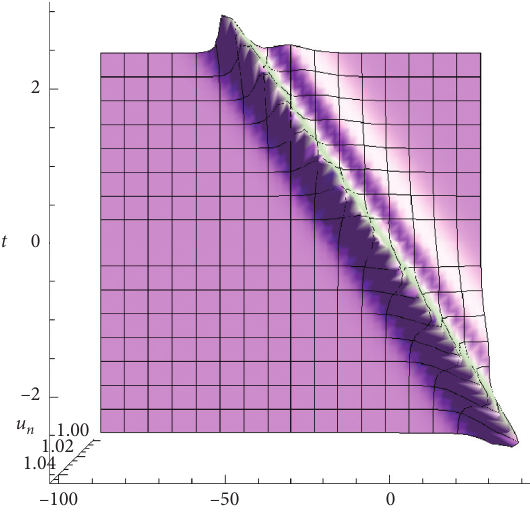
Figure 6: Spatiotemporal structure of the semidiscrete two-soliton solution determined by solution (53) with the parameters α � 1, α � 1, c ( 0 ) � 1, c ( 0 ) � 5 . 5, z α 2 3 1 2